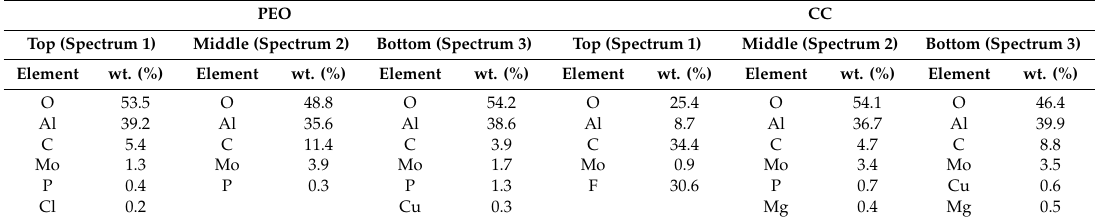
Table 9. Elemental composition at di ff erent locations across coatings’ thickness after 30 days of marine immersion (Figures 16 and